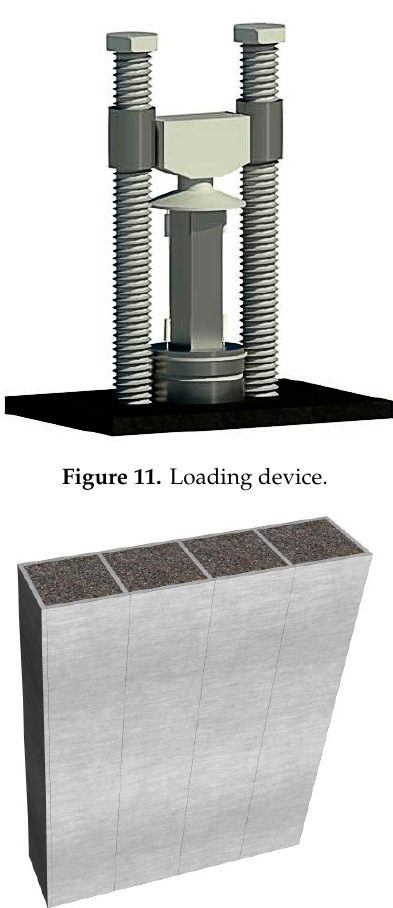
Figure 12. In-line multi-cavity steel tube bundle self-compacting concrete shear wall.